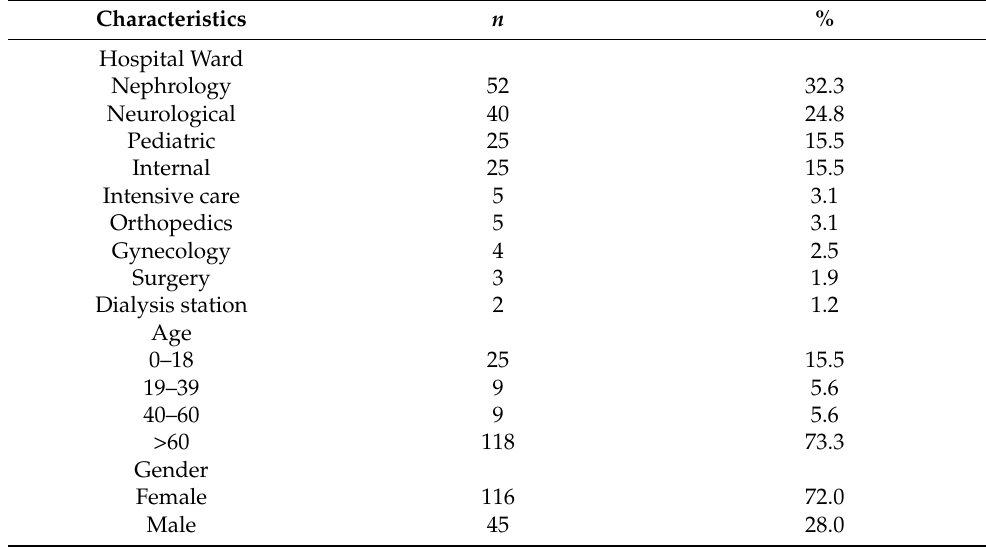
Table 1. Positive urine cultures according to hospital ward, age, and gender of patients.